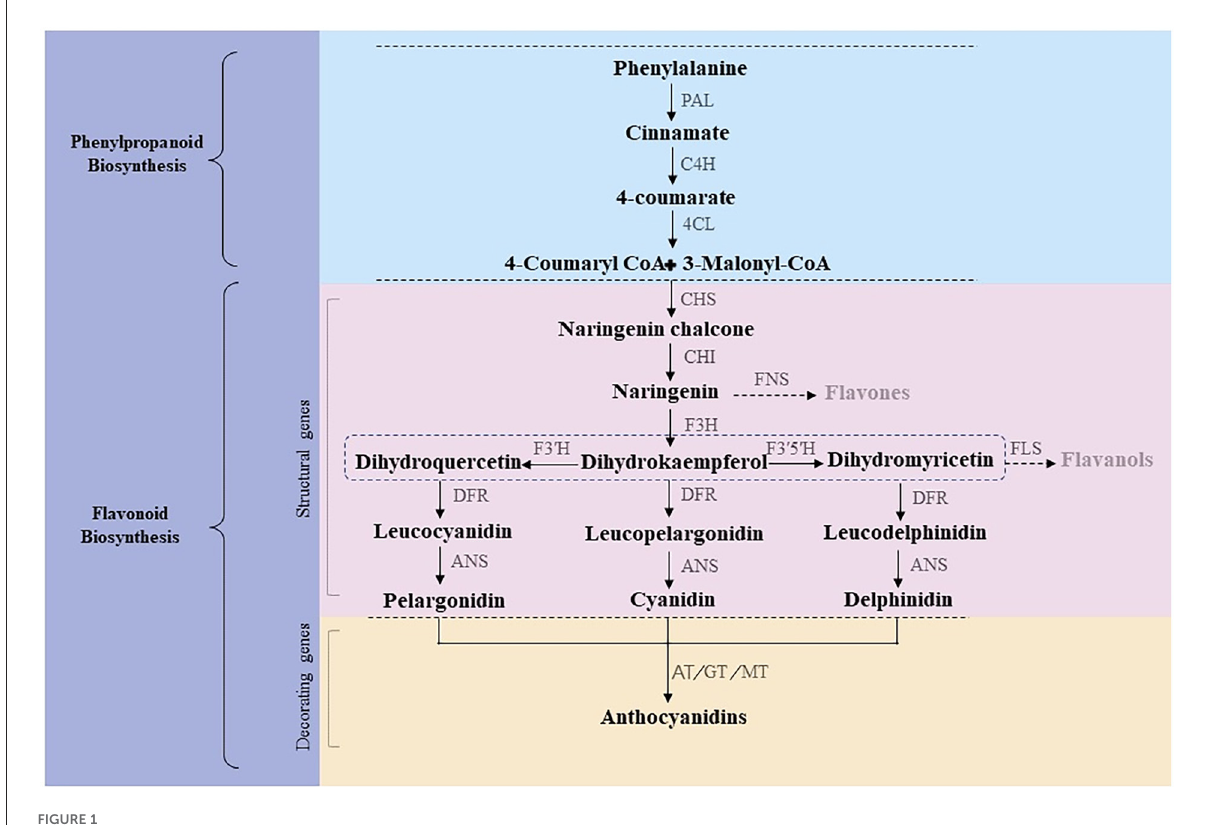
FIGURE1 Anthocyanin synthetic pathway.